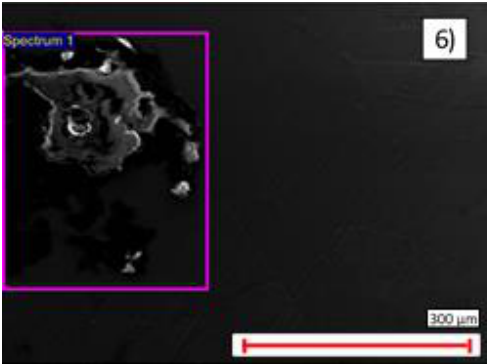
Figure 13. SEM image of contamination on the SS with Ni coating thin-walled pipe (62.7% C, 35.1% Ni, 0.99% Fe, 0.86% O, 0.20% Cr, and 0.13% Al) (6). Table 8. External surface EDX compositions from box scans of identified contamination